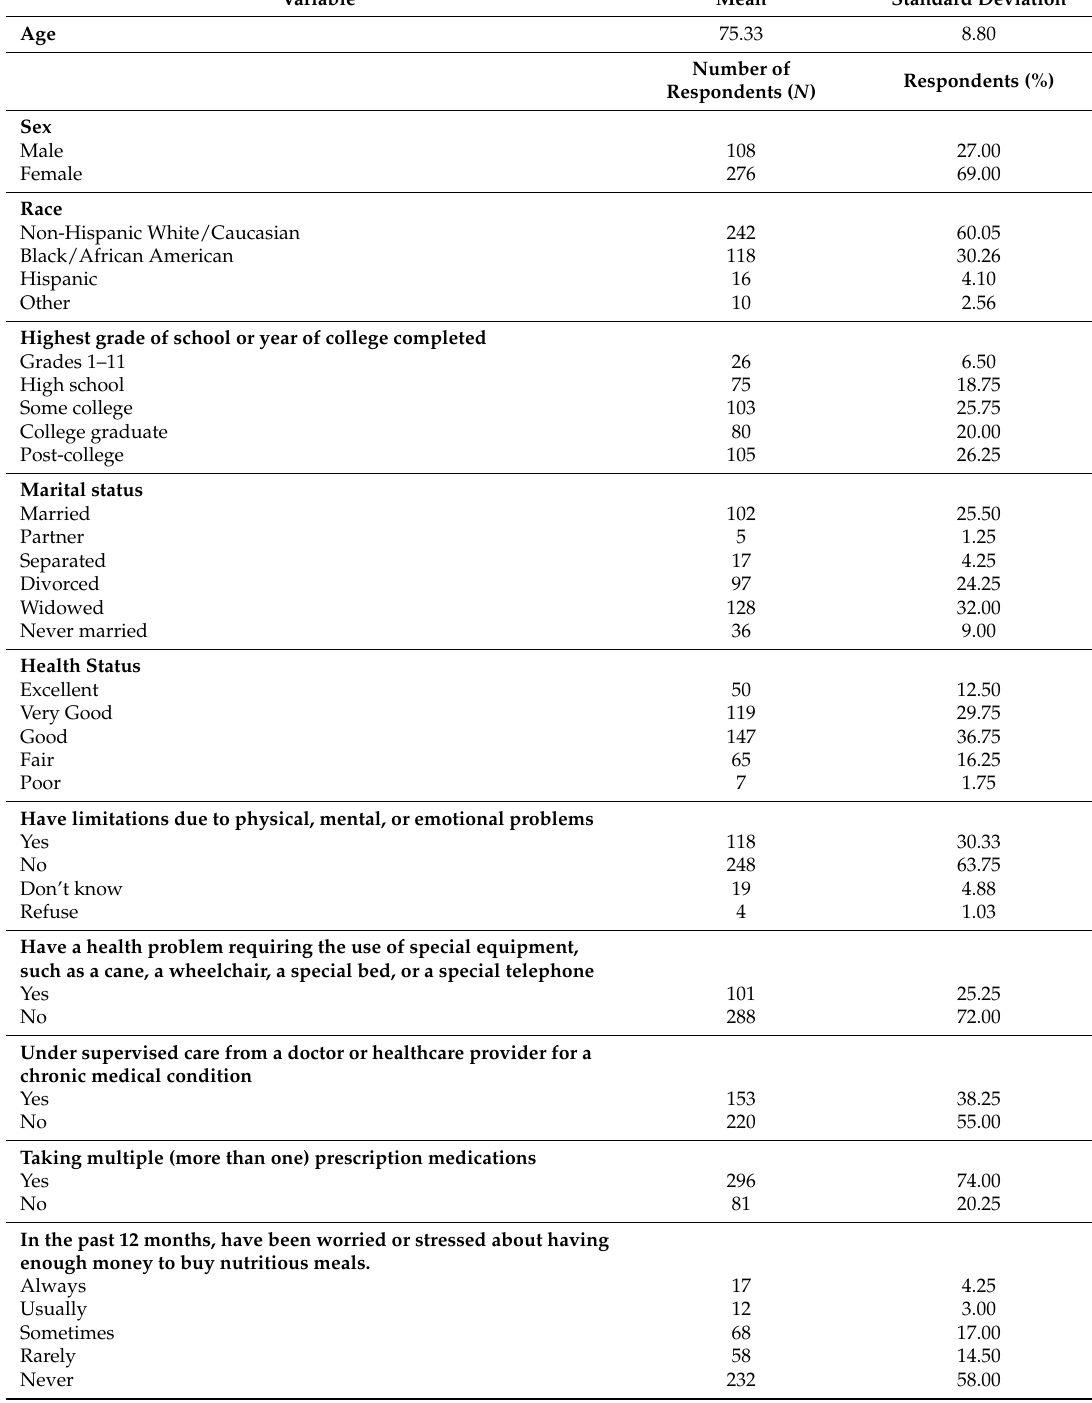
Table 1. Socio-demographics and overall health status among 400